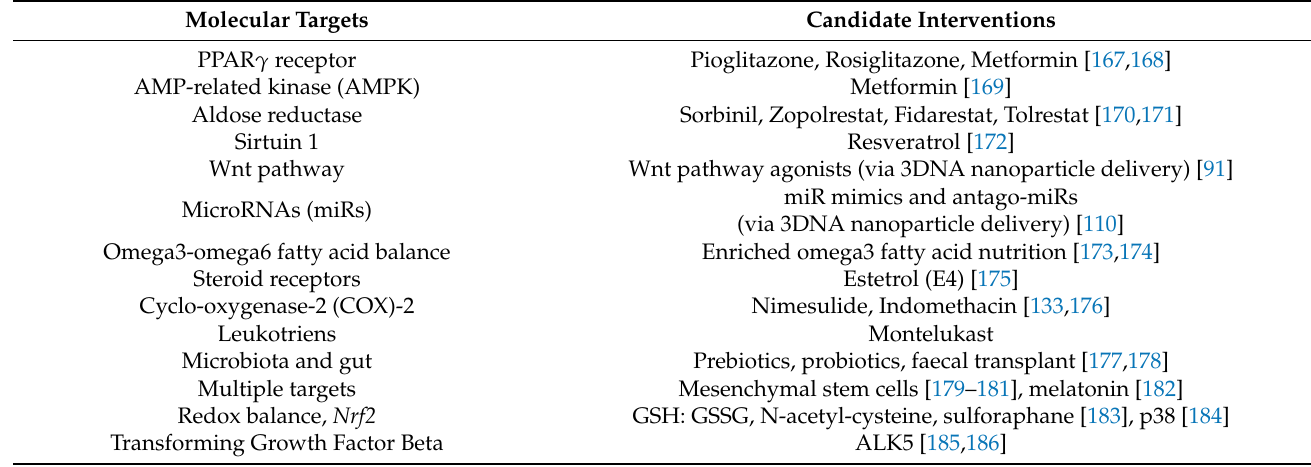
Table 2. Potential therapeutic targets to modulate MG effects in PBIs. Adapted from